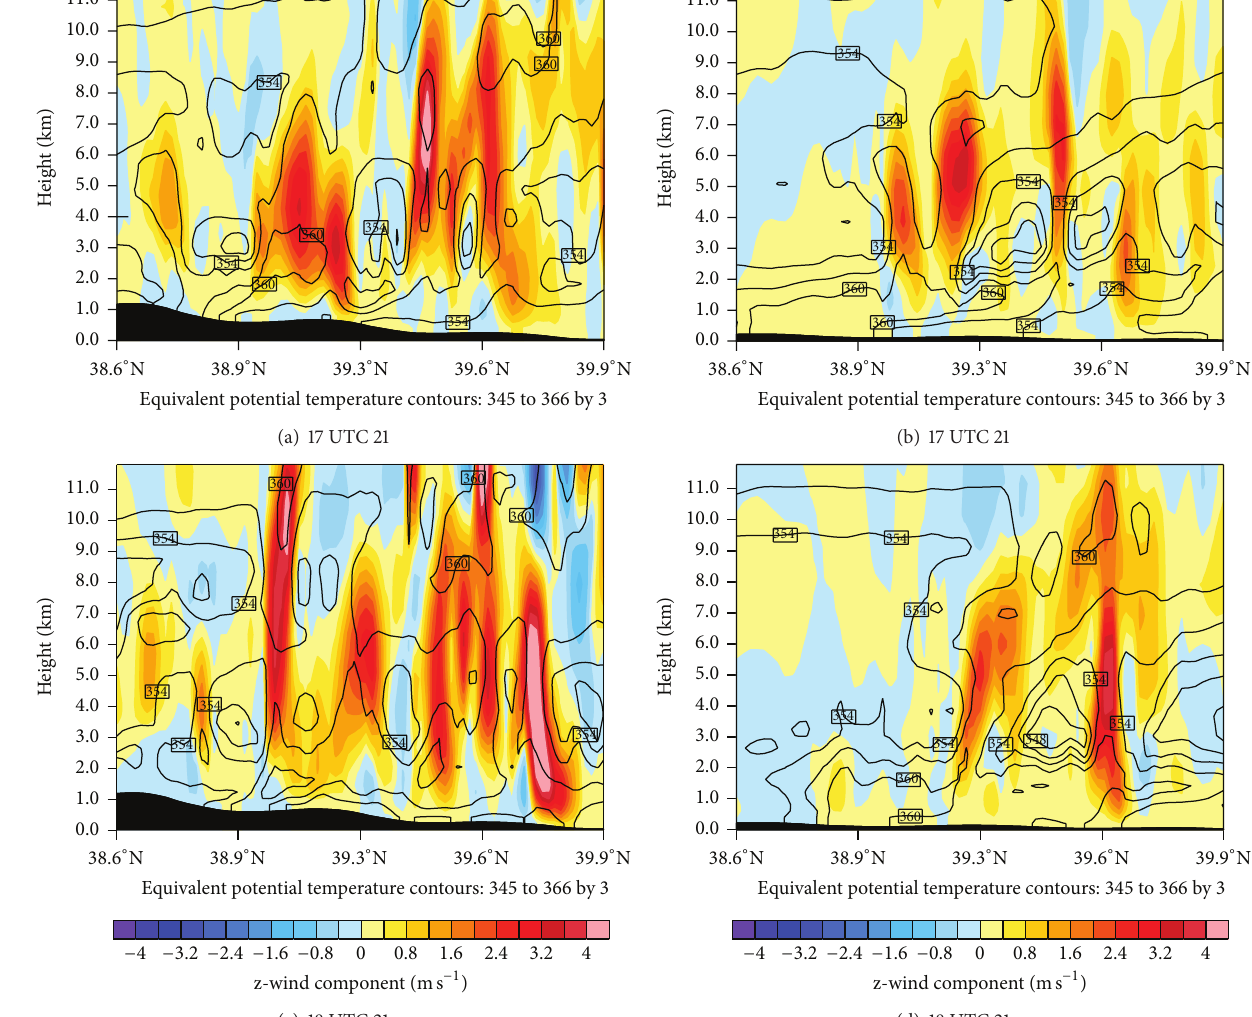
Figure 10: Cross section of vertical motion (shaded, m s −1 ) and equivalent potential temperature (contours) for CTRL experiment at (a) 1700 UTC, (c) 1800 UTC. (b), (d) as in (a) and (c), respectively, but for the TOP0.25 experiment.